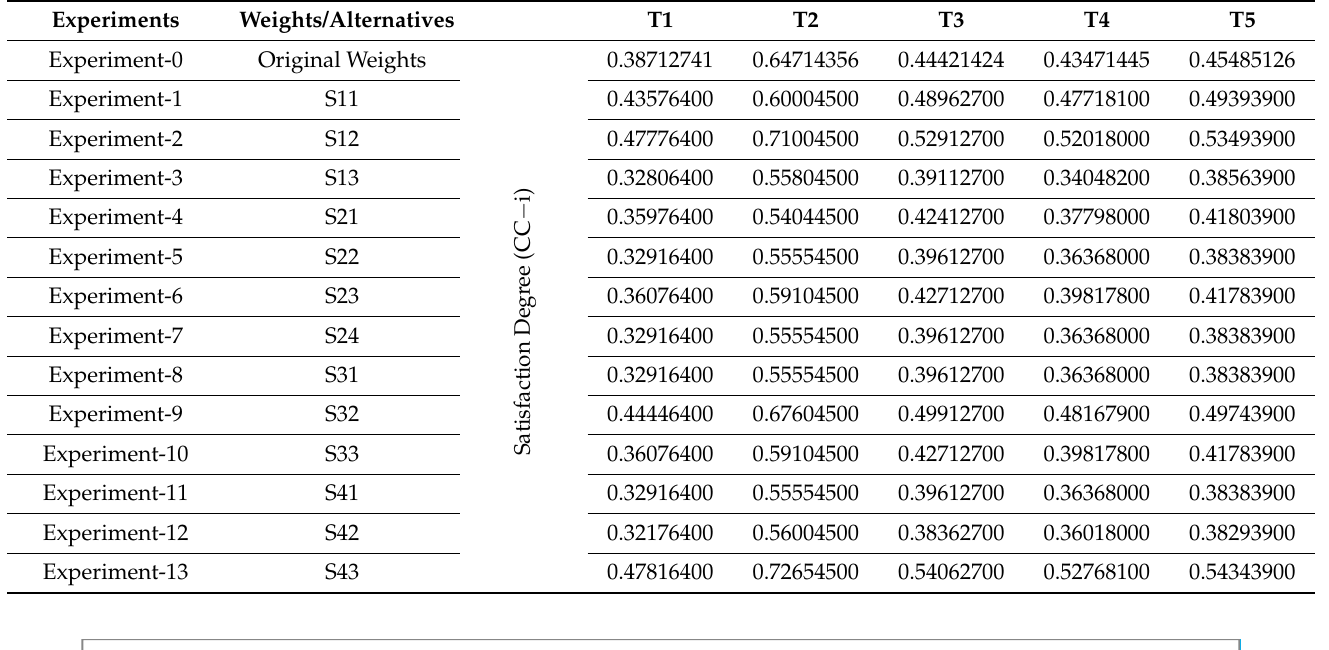
Table 17. The sensitivity analysis.